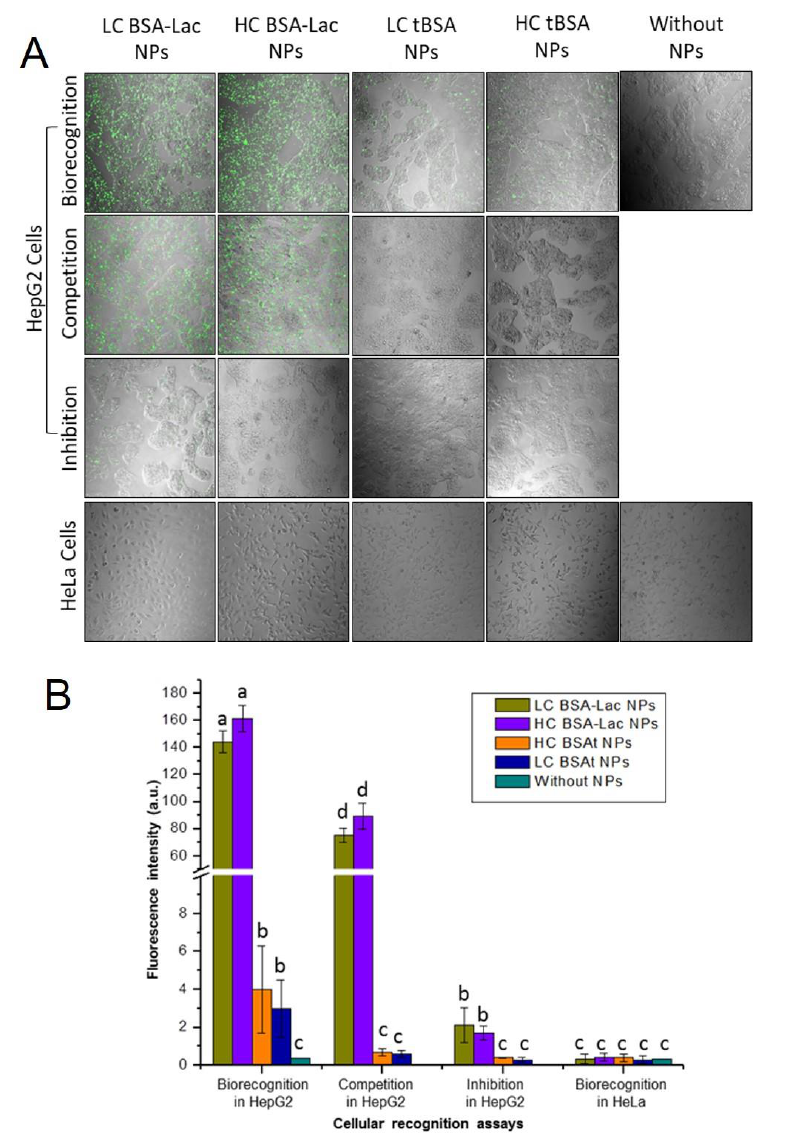
Figure 5. Evaluation of cellular interaction of NPs in human liver cancer (HepG2) and human cervical carcinoma (HeLa) cells. ( A ) Confocal fluorescence images of HepG2 and HeLa cells with LC or HC BSA-Lac NPs. NPs were labeled with fluorescein isothiocyanate (FITC). ( B ) Quantitative analysis of fluorescence intensity of HepG2 and HeLa cells exposed to NPs samples. Experiments were performed in triplicate and analysis by ANOVA followed by Tukey’s test; p ≤ 0.05. Different letter (a, b, c and d) shows statistical